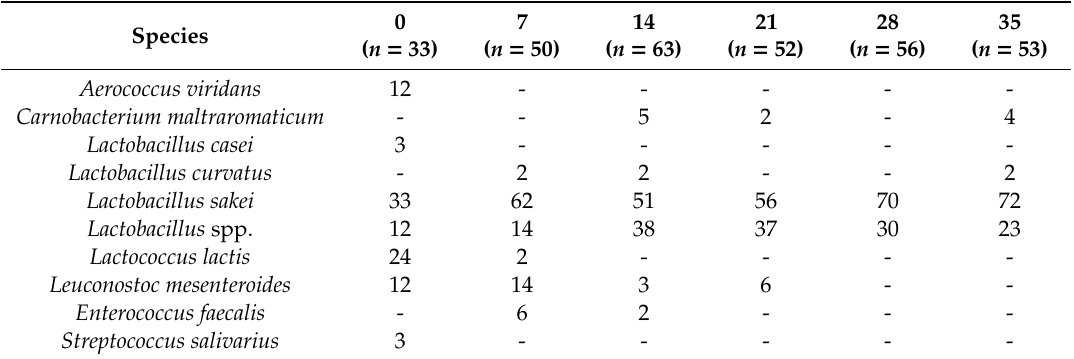
Table 2. Lactic acid bacteria (LAB) species in the sausages # at the di ff erent storage days (expressed in % of total isolates identified as